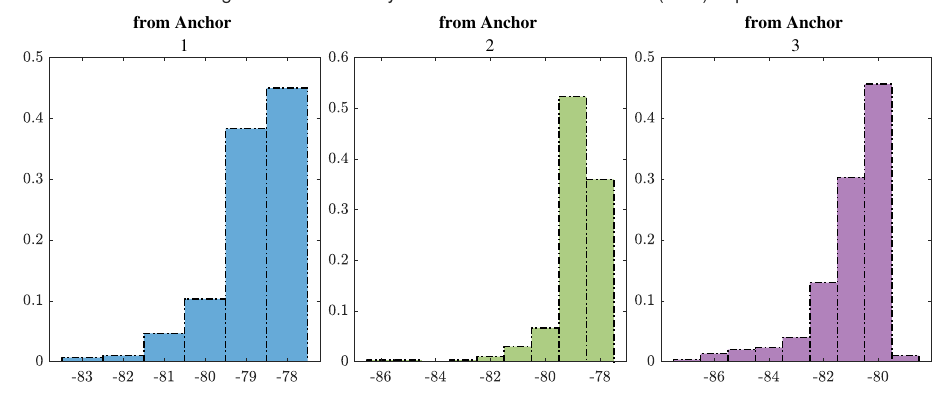
Figure 16. Distribution of RSS values received from UWB anchors at point 10.